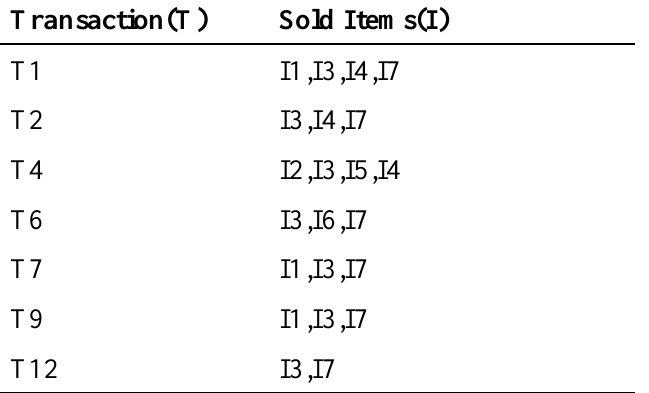
Table 3. Table of Transactions After Deleting Some Useless